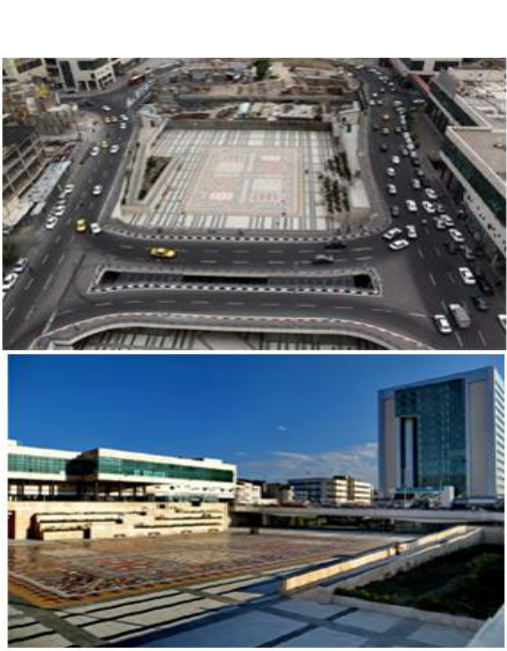
Fig. 3: Green Space in Shahid Beheshti Square Fig. 4: Connectivity and walking in Shahid Beheshti